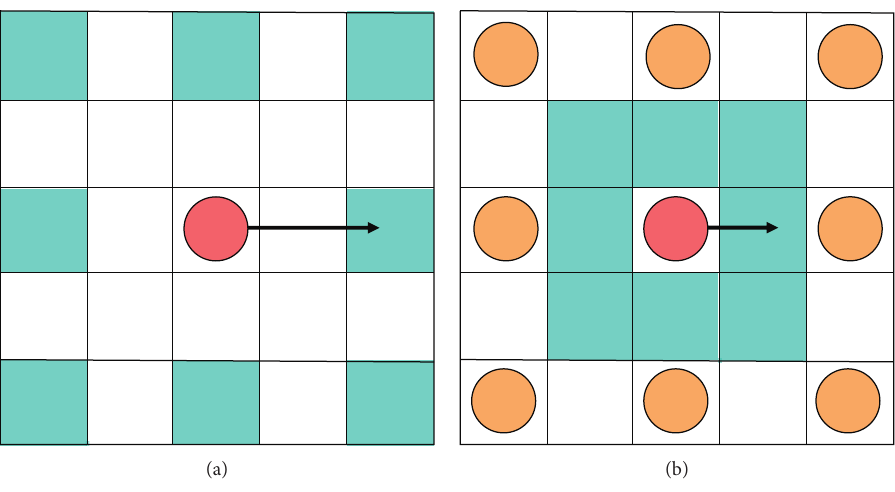
Figure 11: Target cell of “impulsive.”